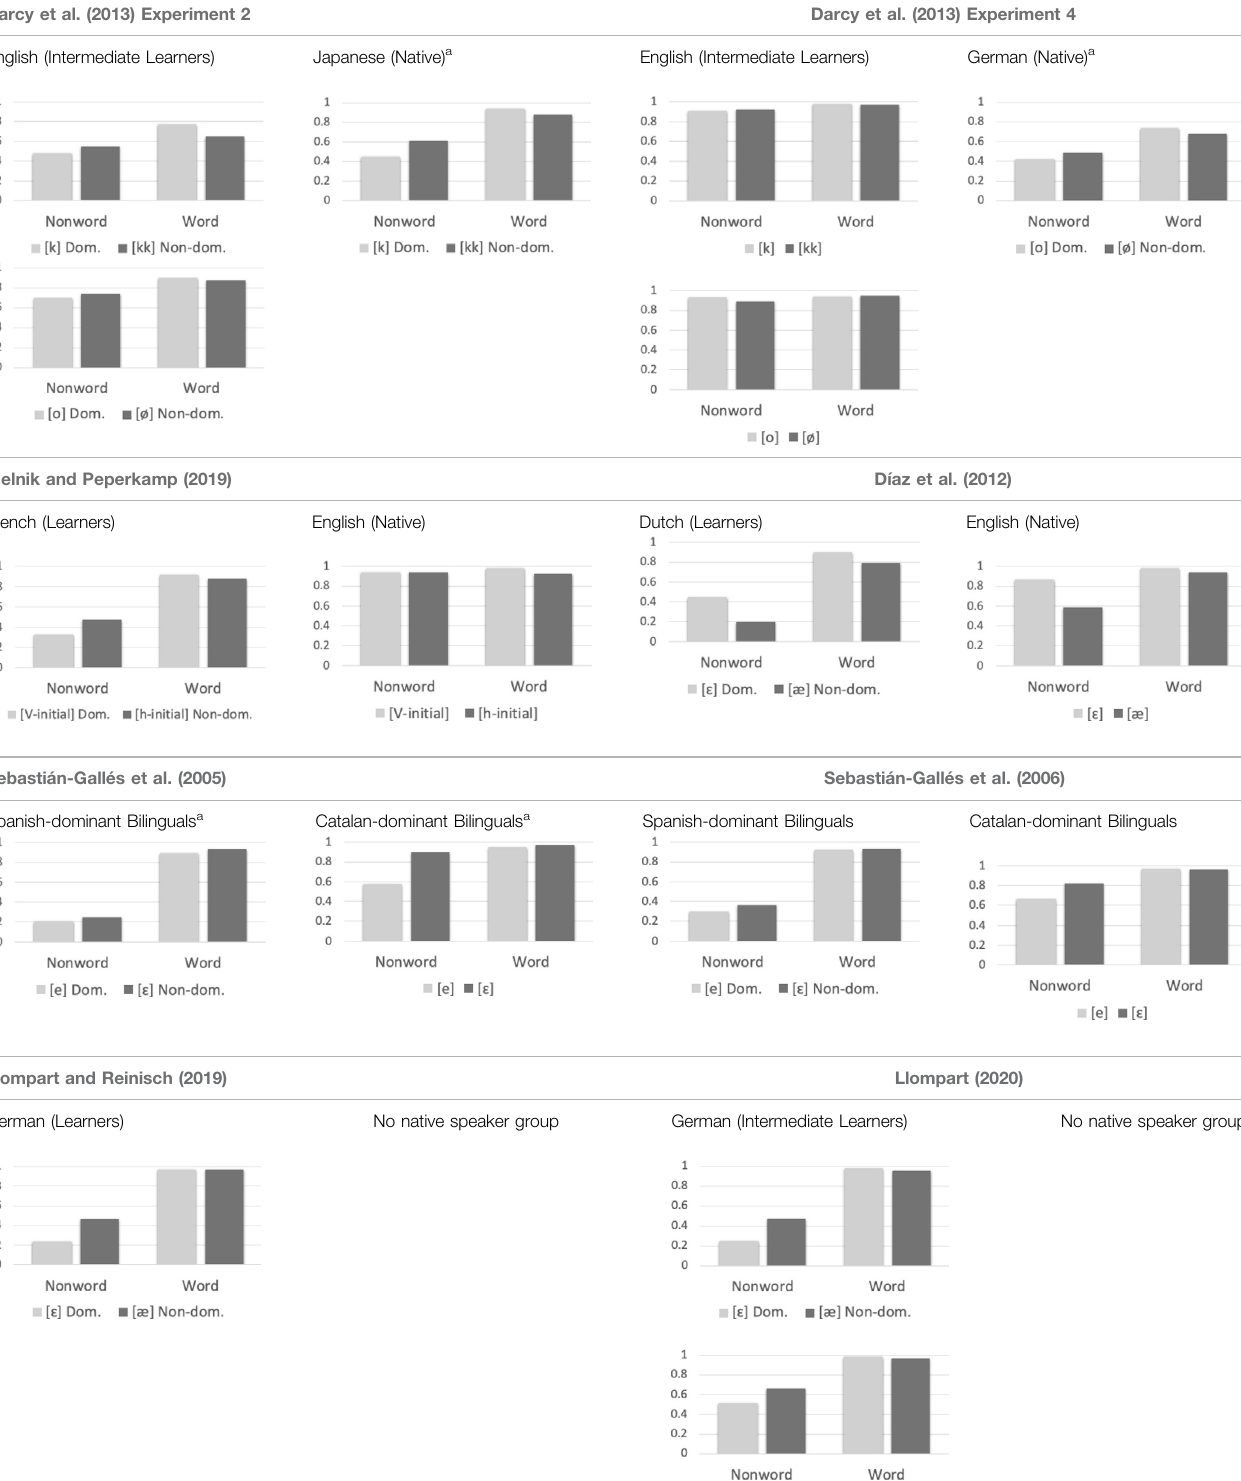
TABLE 1 | Summary of LD fi ndings of previous studies (vertical axis represents mean proportion